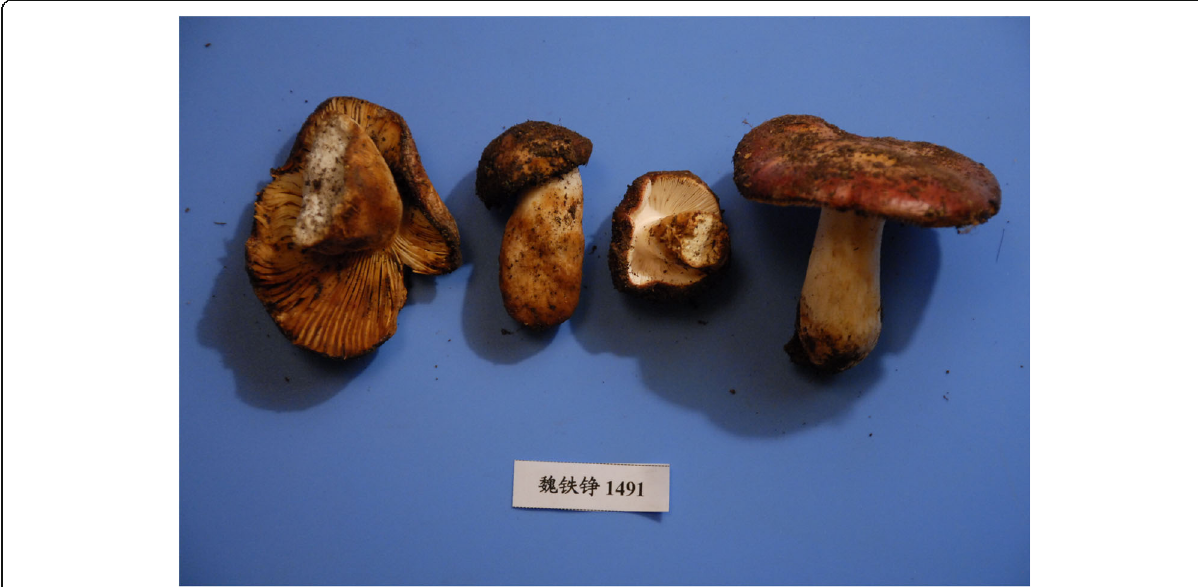
Fig. 5 Russula tengii (HMAS262728, holotype), field appearance. Bar = 1 cm. Photo: